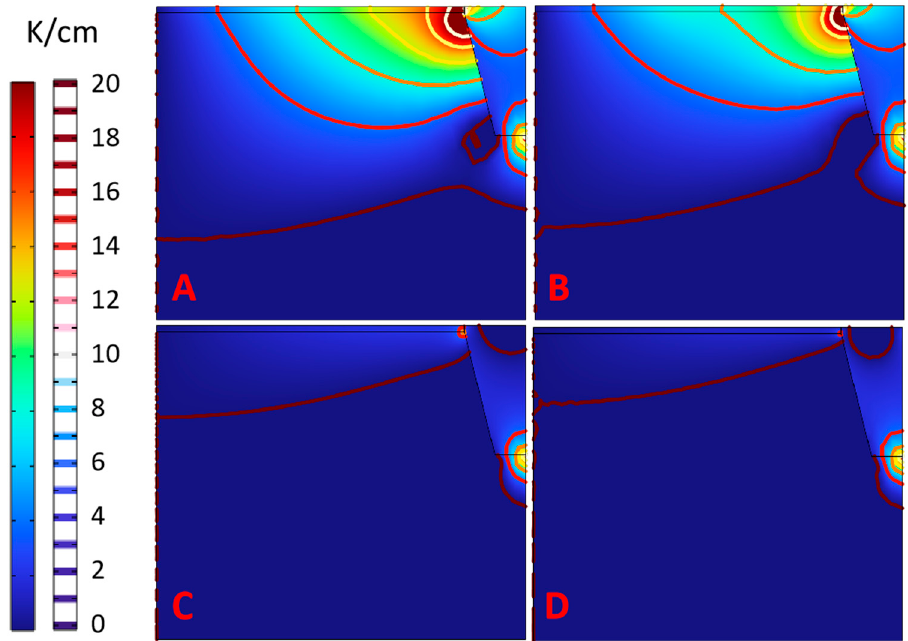
Figure 4. Radial temperature gradient in the chamber. ( A ) Scheme A; ( B ) Scheme B; ( C ) Scheme C; ( D ) Scheme D.